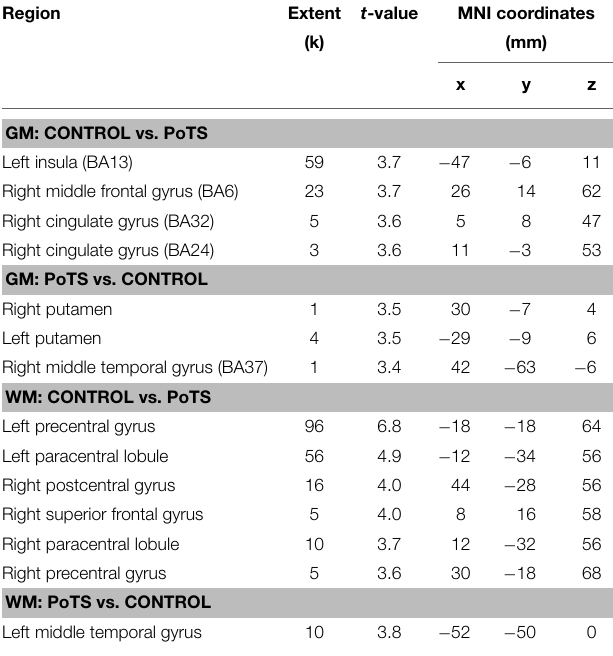
TABLE 1 | Brain region and peak significance of gray matter (GM) and white matter (WM) volume reduction by group comparison using VBM-DARTEL.